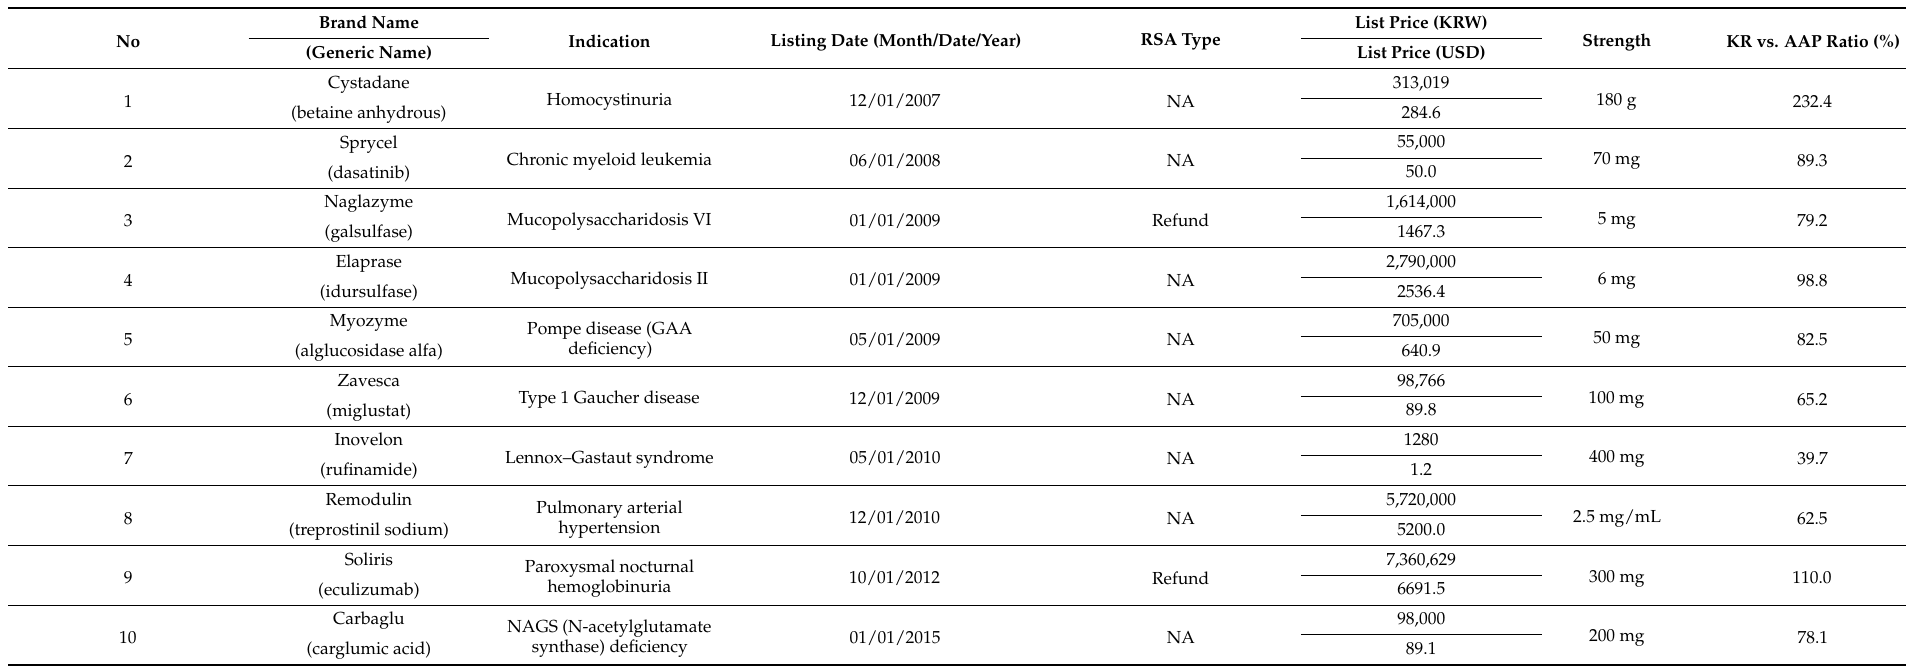
Table 2. New orphan drugs evaluated as essential drugs in South Korea (listed during the period January 2007–March